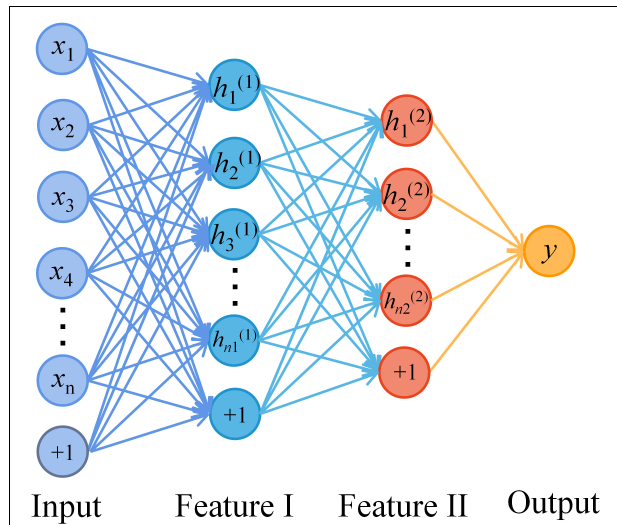
FIGURE 2 | The structure diagram of the stacked auto-encoder (SAE) neural network. A four-layer SAE neural network with double hidden layers was selected for AD classification. The neurons of all layers are connected in a fully connected way. Among them, the number of the input layer neurons is the dimensions of multimodal data. The number of hidden layer neurons is set by the method of selecting the best model. And the output layer is AD or